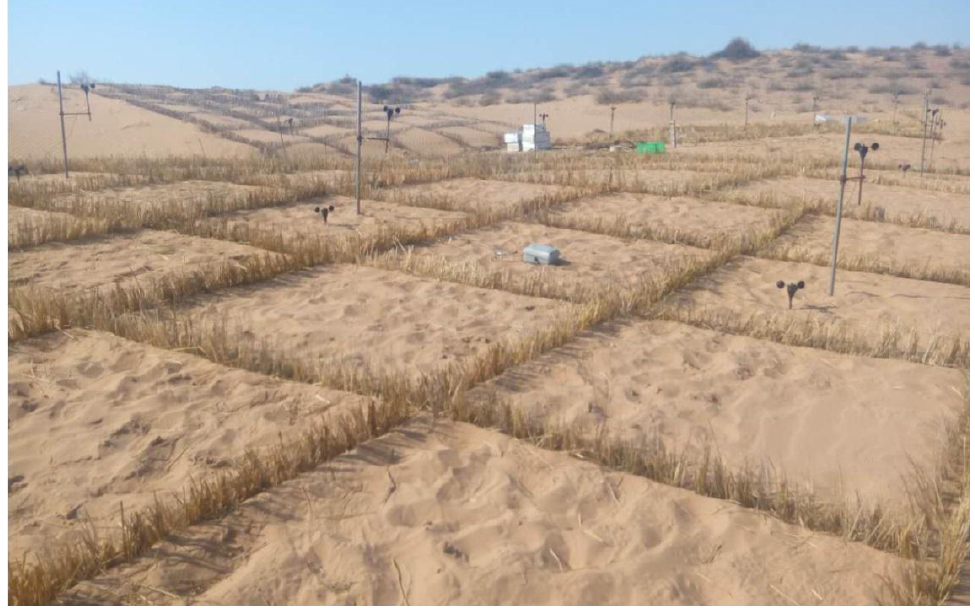
Figure 1. Semi-buried straw checkerboard.